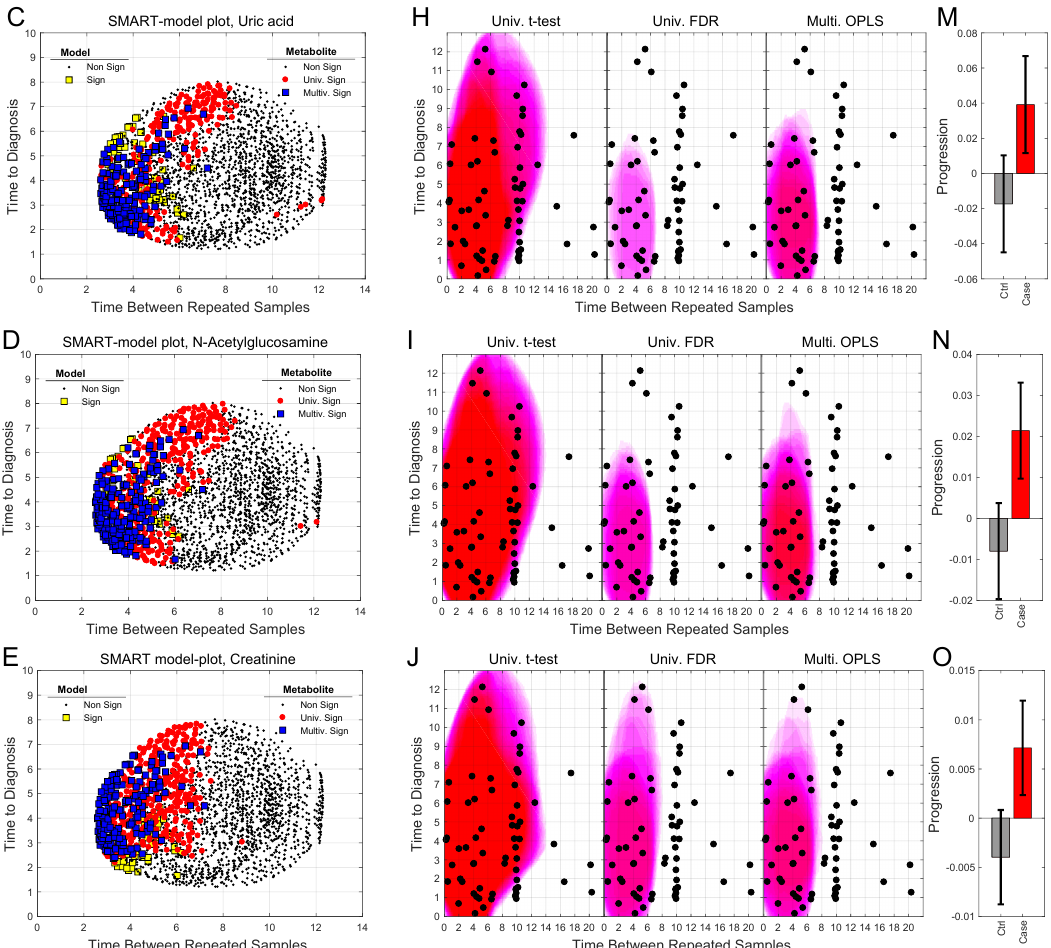
Figure 3. SMART-model and SMART-observation plots, and progression patterns for individual metabolites: myo-inositol ( A , F , K ), cysteine ( B , G , L ), uric acid ( C , H , M ), N-acetylglucosamine ( D , I , N ) and creatinine ( E , J , O ). ( A – E ) SMART-model plot for individual metabolites. The shape and color of the symbols relate to the statistical significance. For model: black dot; non-significant model, yellow square; significant model. For individual metabolite: black dot; non-significant metabolite, red dot; significant metabolite in univariate t -test, blue square; multivariate significant metabolite (w and p). ( F – J ) SMART-observation plots for individual metabolites. The SMART-observations plot is similar to the plot in Figure 2C but highlights the distribution pattern for subsets where the individual metabolites are significant, instead of models. Distribution pattern for three significance criteria are illustrated. Left panel: univariate t -test. Middle panel: univariate t -test with correction for Benjamini–Hochberg false discovery rate (FDR) < 0.2. Right panel: multivariate significance using loadings w and p. Distribution patterns shown in red color indicate significantly increased levels of the individual metabolite in cases compared to controls, while patterns shown in blue indicate significantly reduced levels of the metabolite in cases compared to controls. ( K – O ) Progression pattern for individual metabolites. Mean progression of metabolite levels for cases and controls in the defined region of interest for glioma. Confidence intervals (95%) based on a dependent two-sided t